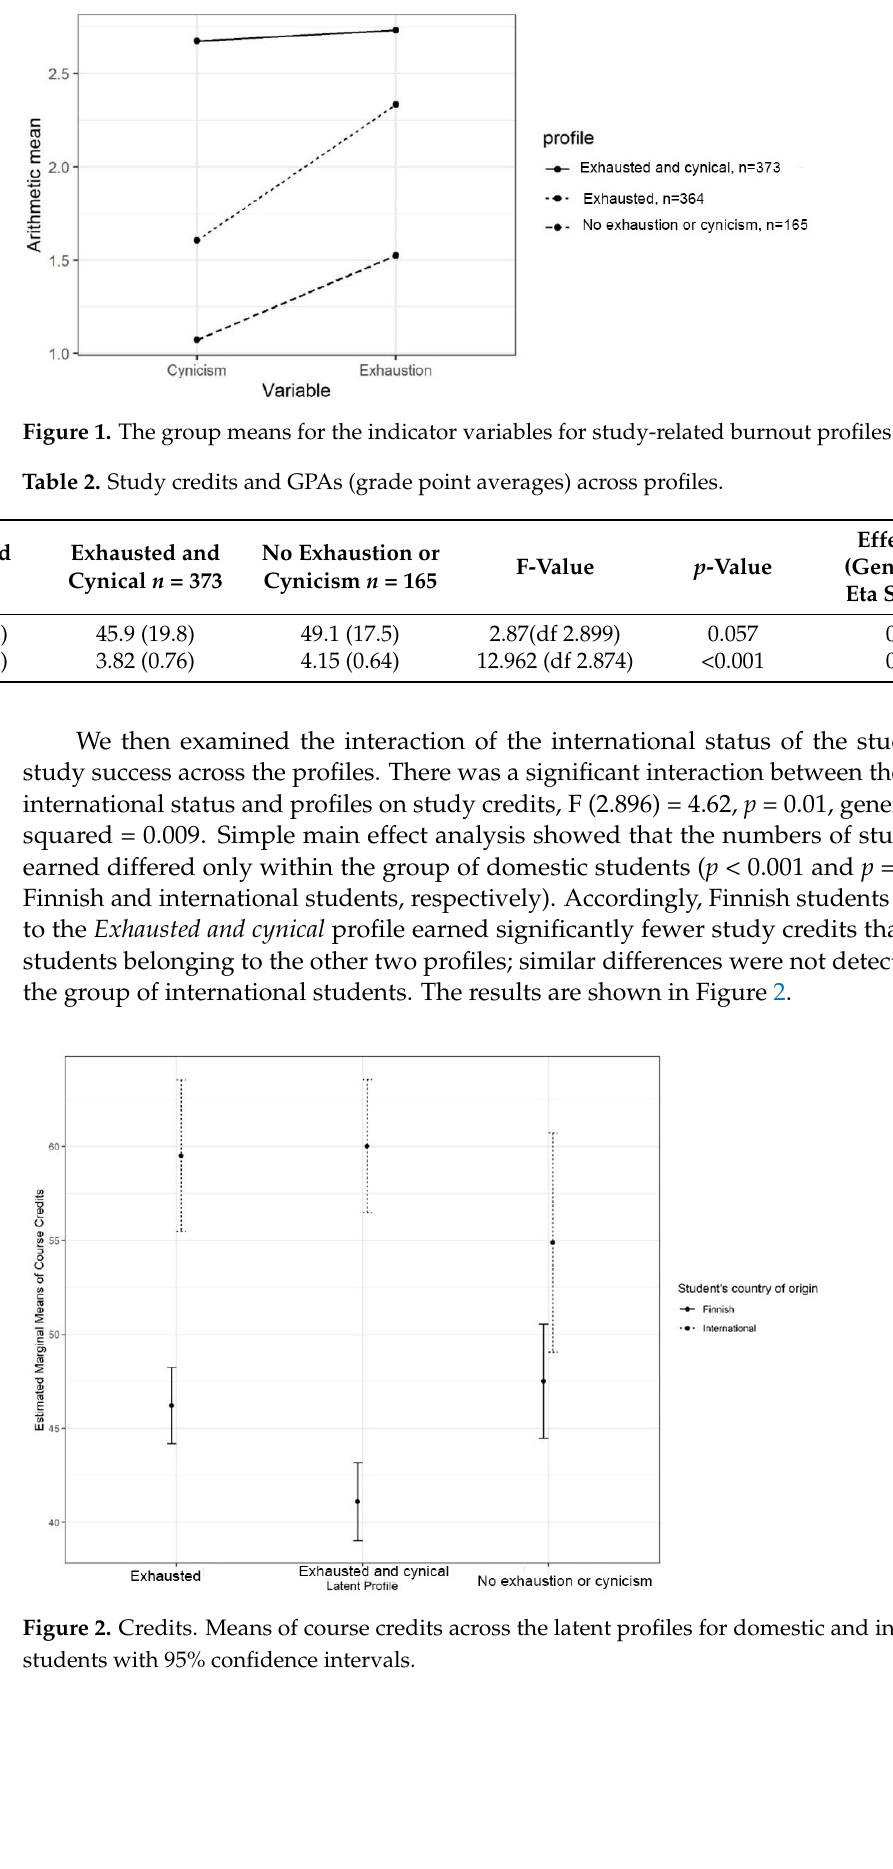
Figure 3. Means of GPAs across the latent profiles for domestic and international students with 95% confidence intervals. It is of interest to compare the pattern of results concerning study credits and GPAs: when it comes to the former, the interaction between the burnout profile and the student’s international status was significant, whereas when it comes to the latter, it was not. The main effect of burnout profile was still significant, reflecting the fact that students belonging to burnout profile Exhausted and cynical had the lowest GPAs, students belonging to profile No exhaustion or cynicism the highest GPAs, and students belonging to profile Exhausted something were in between the other two profiles.